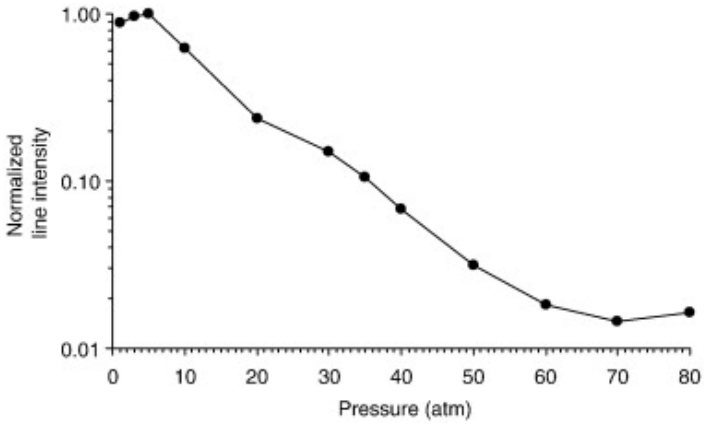
atmosphere. Reprinted from 2